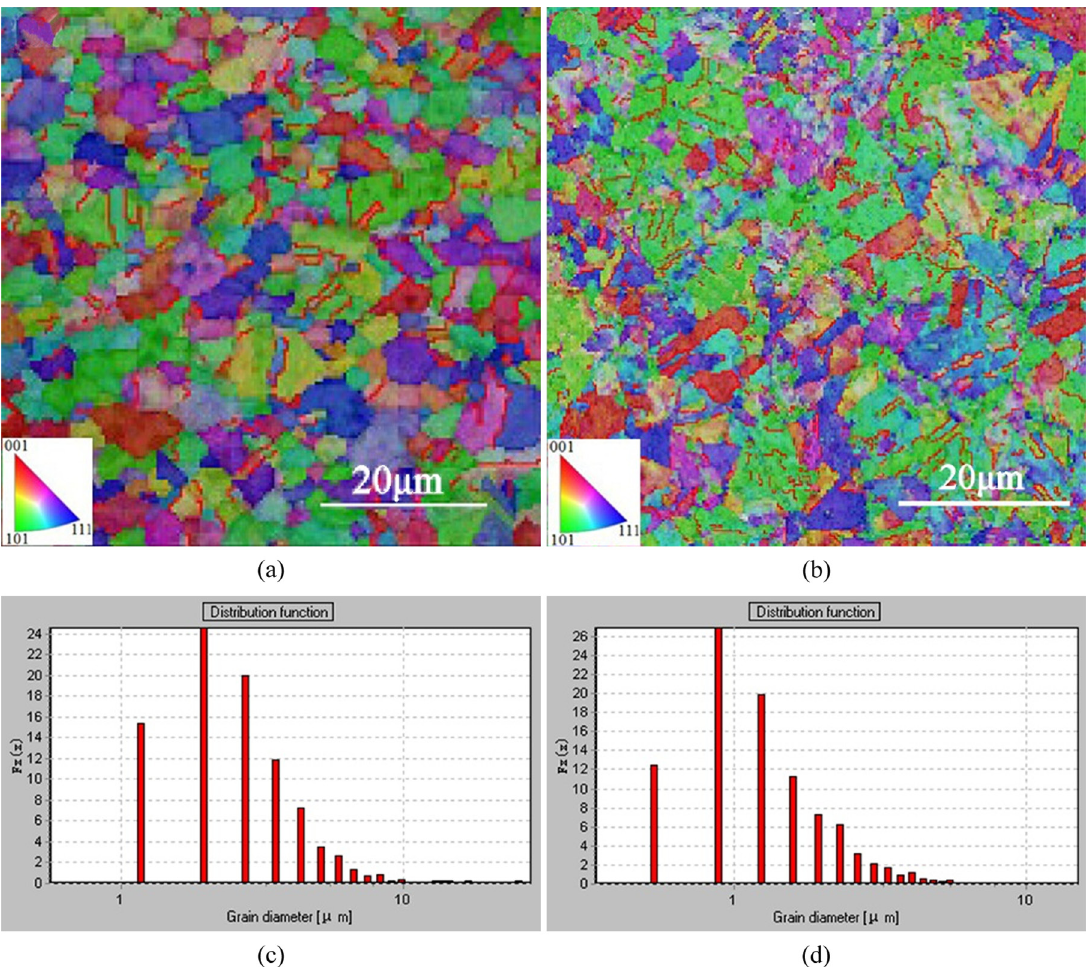
Figure 1. (a) and (b) The crystal orientation Z-axis IPF contrast maps of the first sample and the second sample; (c) and (d) The grain diameter distribution function of the first sample and the second sample;